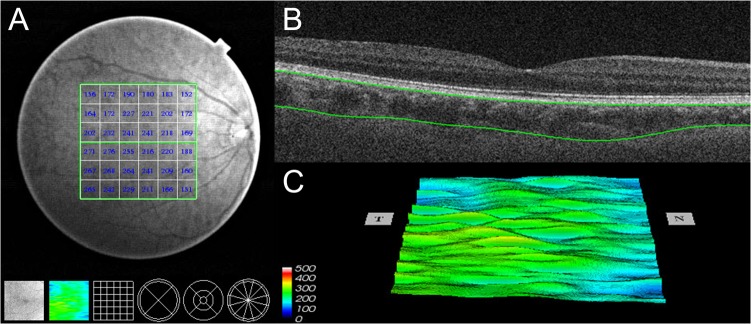
SS-OCT measurement.SS-OCT image showing the measurements of choroidal thickness. (A) Choroidal thickness map of the 6×6 mm area centered on the fovea was created. The mean choroidal thickness was obtained for each sector. (B) Automatic placement of the chorioscleral border made by the automatic built-in software in one of the B-scan images of the 3D data set. (C) Choroidal topographic map of the 6×6 mm area.